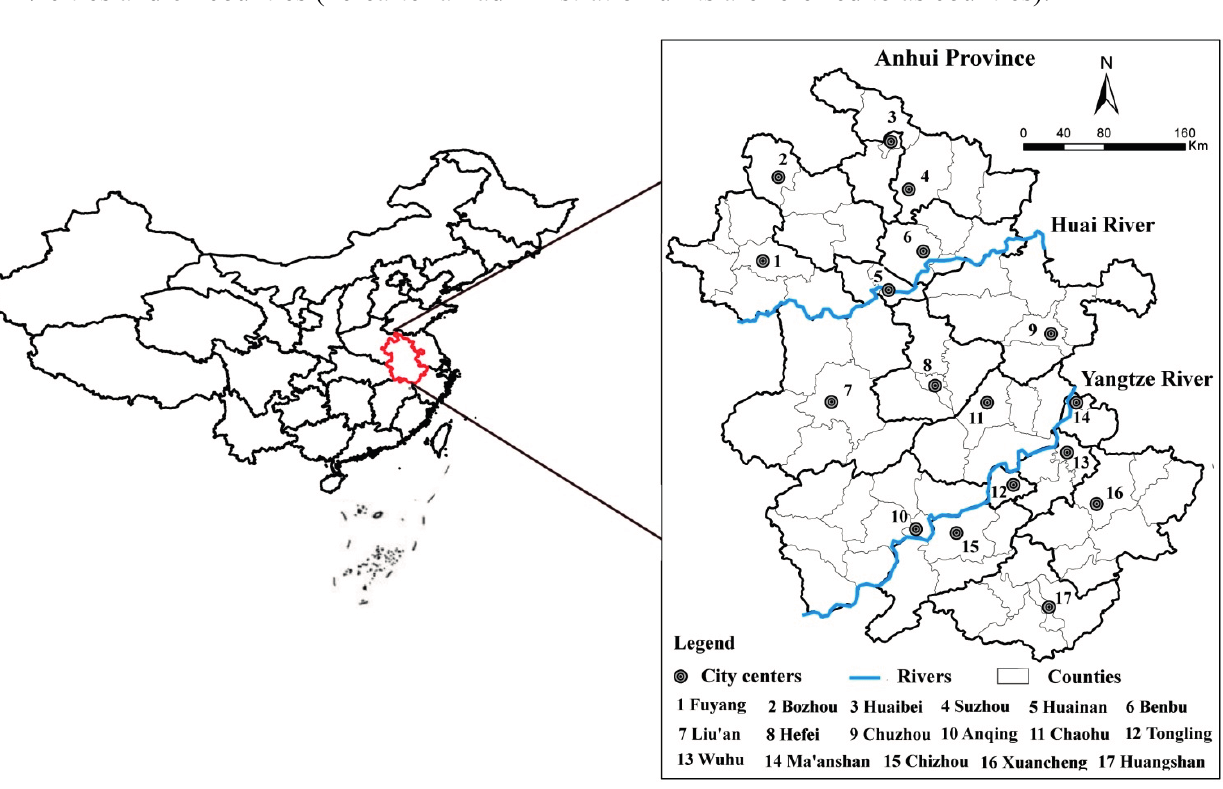
Figure 3. Location of the study area and its